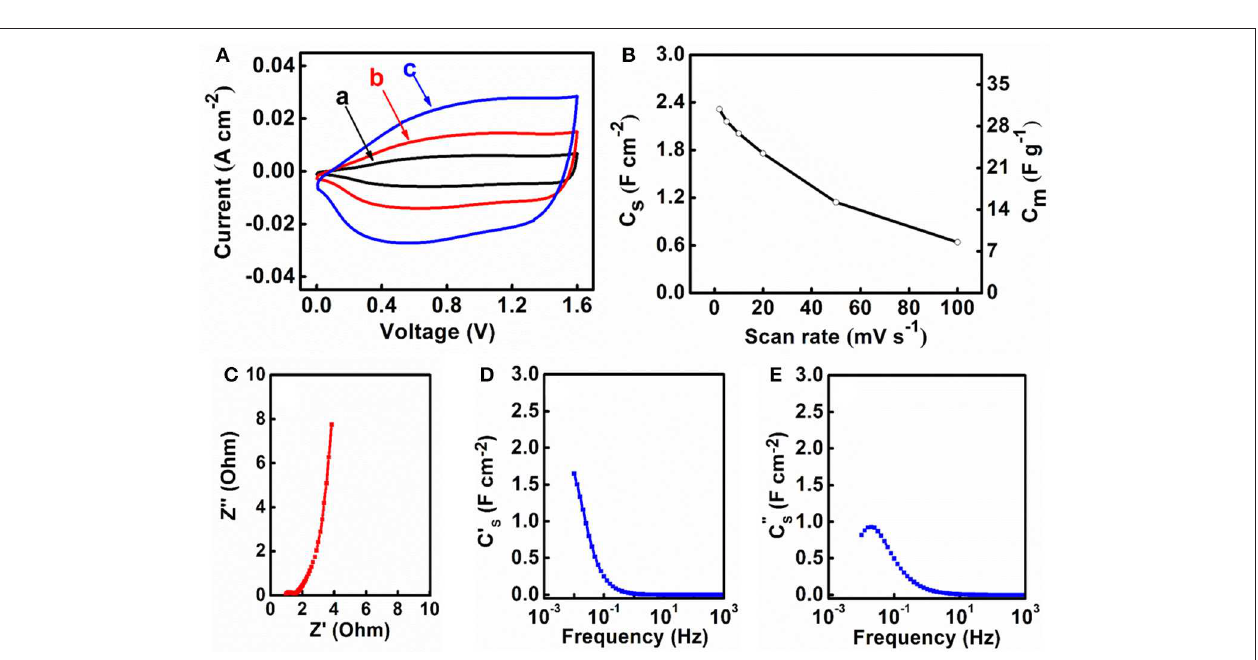
FIGURE 8 | (A) CVs at scan rates of (a) 2, (b) 5 and (c) 10mV s − 1 , (B) C S and C m calculated from the CV data vs. scan rate, (C) Nyquist plot of complex impedance and frequency dependences of (D) C ′ s and (E) C ′′ s for an asymmetric supercapacitor cell, containing M-FH-CB-MWCNT as a negative electrode and MnO 2 -MWCNT as a positive